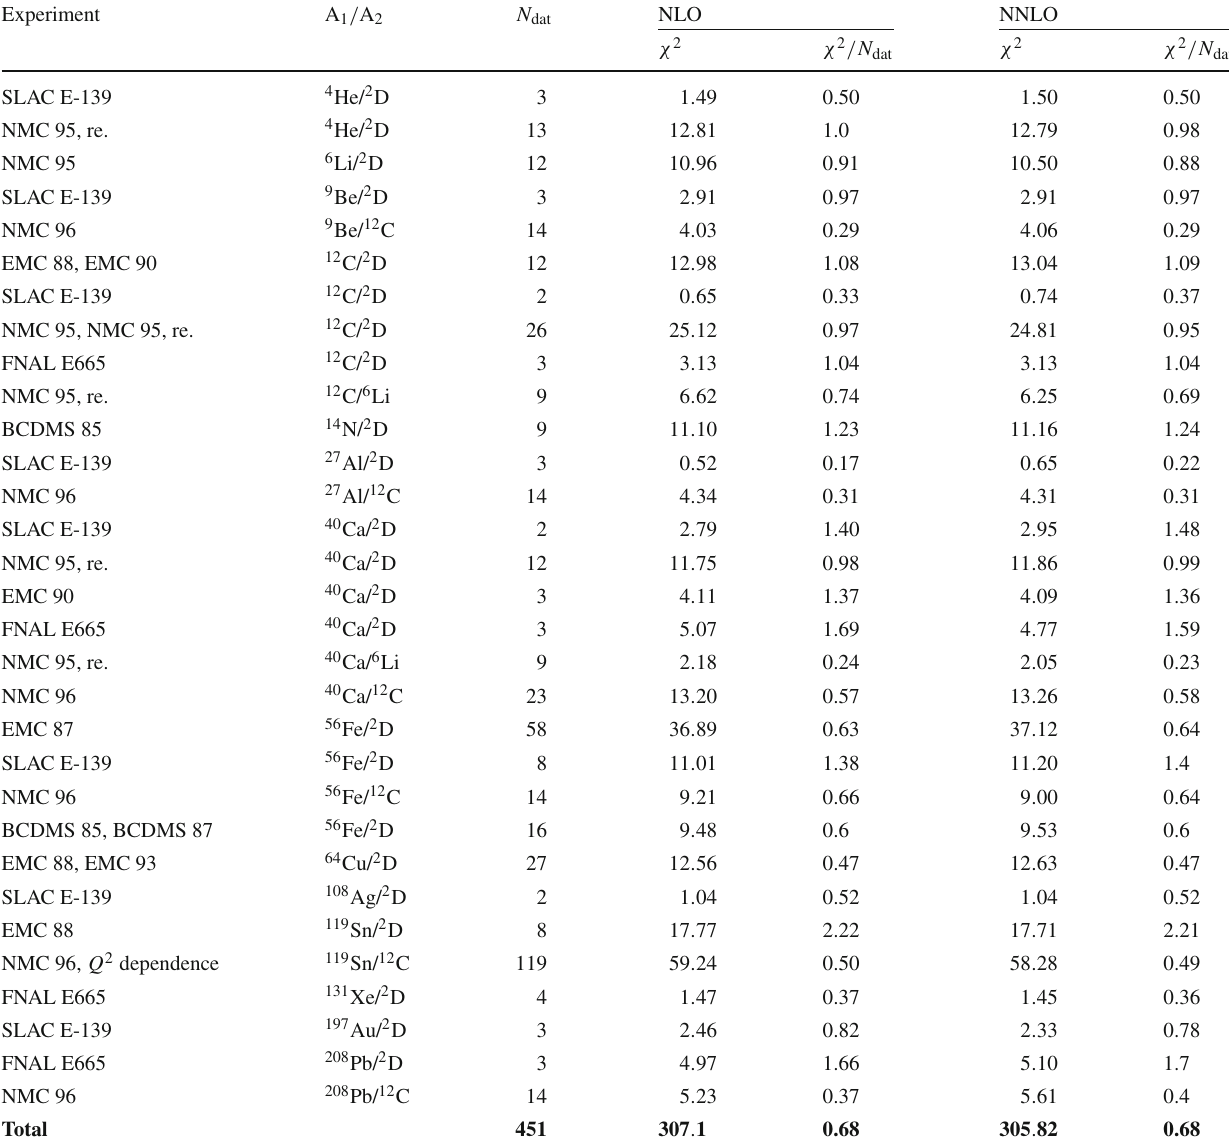
Table 5 Same as Table 1, now indicating the absolute and normalized values of the χ 2 for each of the input datasets as well as for the total dataset. Listed are the results for both the NLO and NNLO nNNPDF1.0